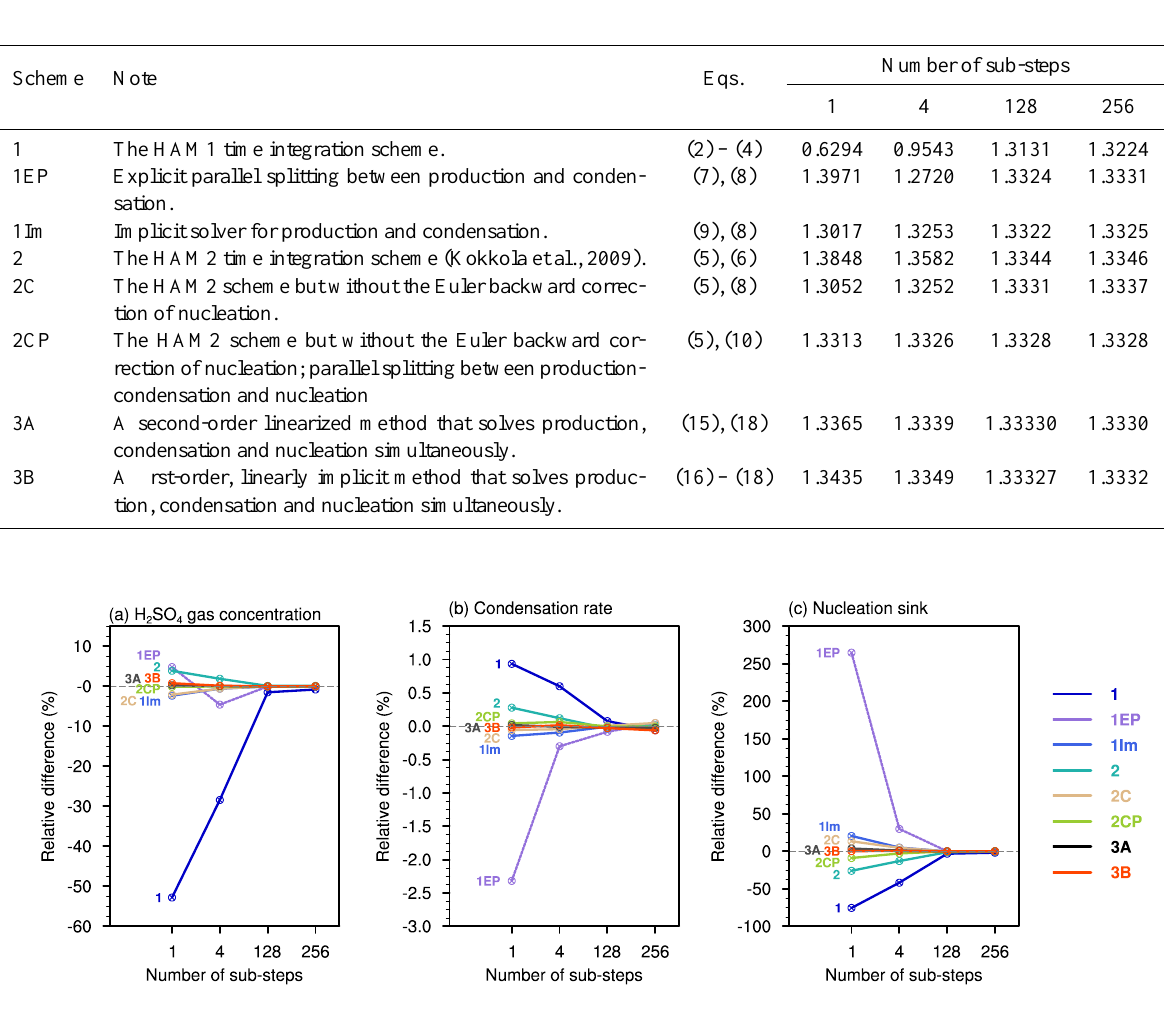
Fig. 2. Convergence plots for the globally integrated annual mean H 2 SO 4 gas (a) concentration, (b) condensation rate, and (c) loss rate due to aerosol nucleation, showing the relative differences with regard to reference solution, given by different time stepping schemes and numbers of sub-steps used for integrating the sulfuric acid equation (Eq. 1). The numerical schemes noted by labels in the figure are described in Table 1 and Sect. 2.2. The reference solution is established in Sect.